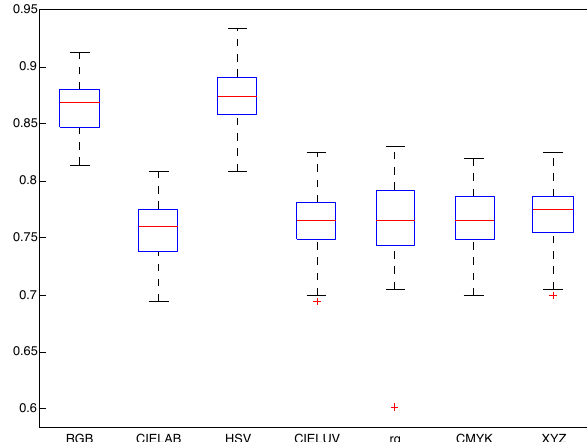
Figure 3: Color histogram [13] evaluation using several color spaces: red-green-blue (RGB), CIE Lightness-ab (CIELAB), hue-saturation- value (HSV), CIE Lightness-uv (CIELUV), red-green (rg), cyan- magenta-yellow-black (CMYK), and tristimulus values (XYZ).